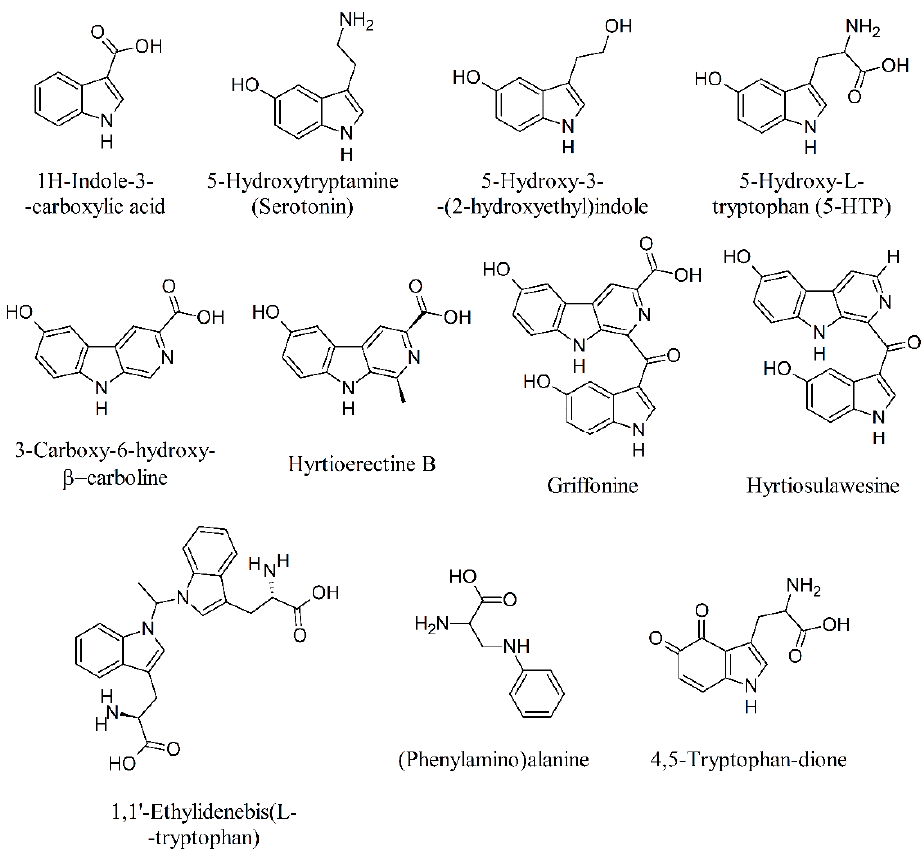
Figure 1. Structures of different isolated N-containing compounds from G. simplicifolia .